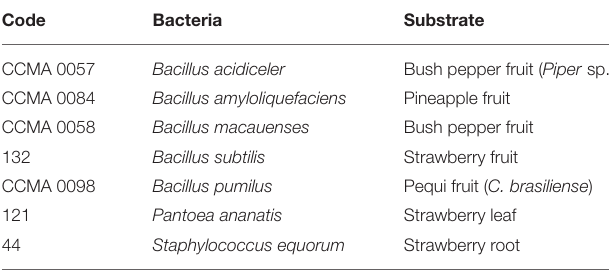
TABLE 1 | Identification and origin of